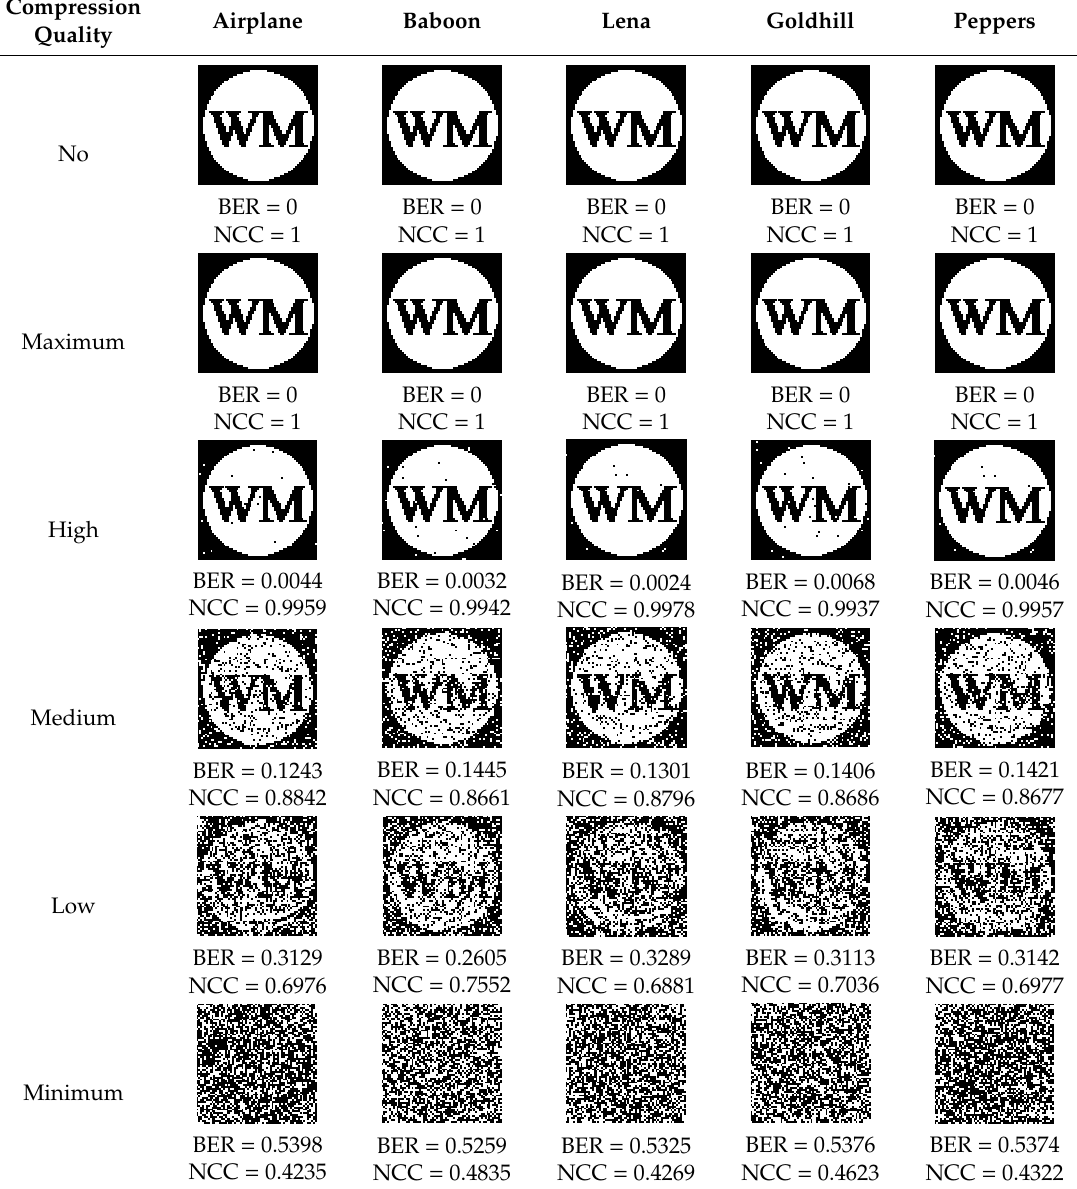
Table 2. Watermarks extracted from highly detailed watermarked images obtained by the algorithm [31].